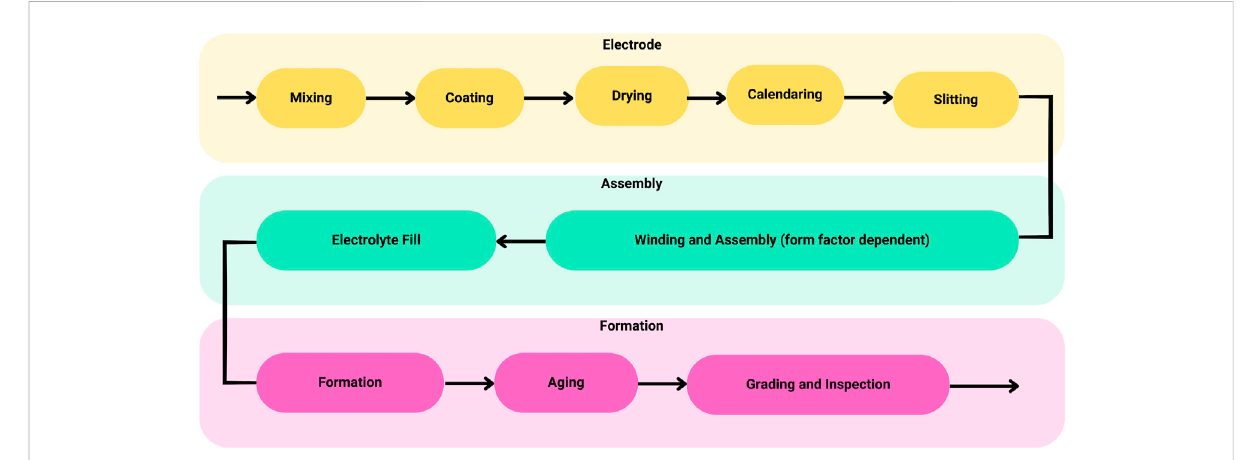
FIGURE 5 Three phases of processes involved in cell production.